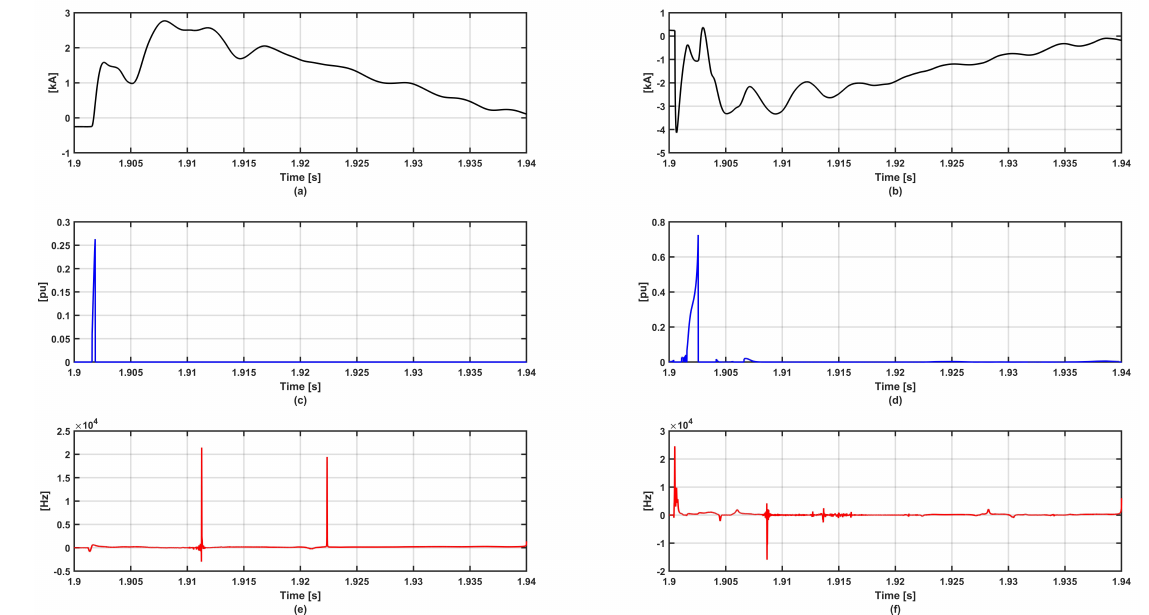
Figure 5. Simulation results for fault I. ( a ): RP3 current ( b ): RP4 ( c ): Instant amplitude for RP3 ( d ): Instant amplitude for RP4 ( e ): Instant frequency for RP3 ( f ): Instant frequency for RP4.